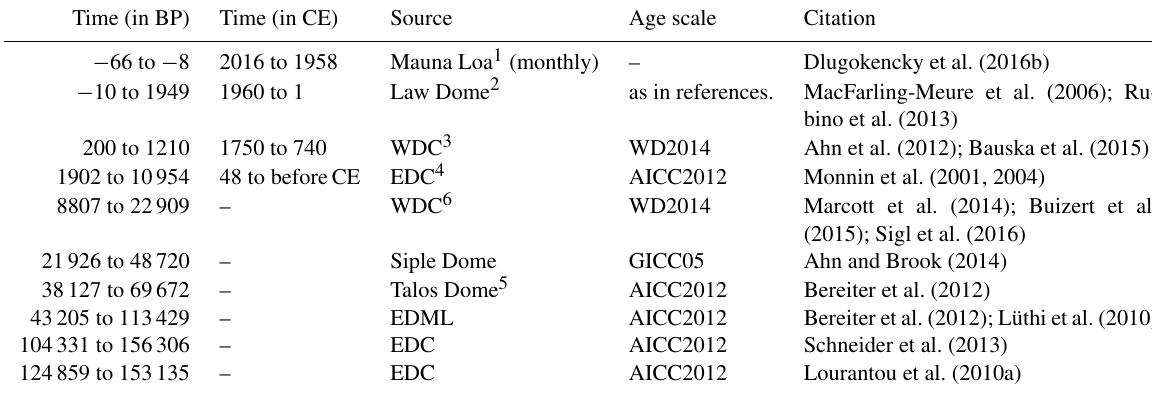
Table 2. Data used to construct the CO 2